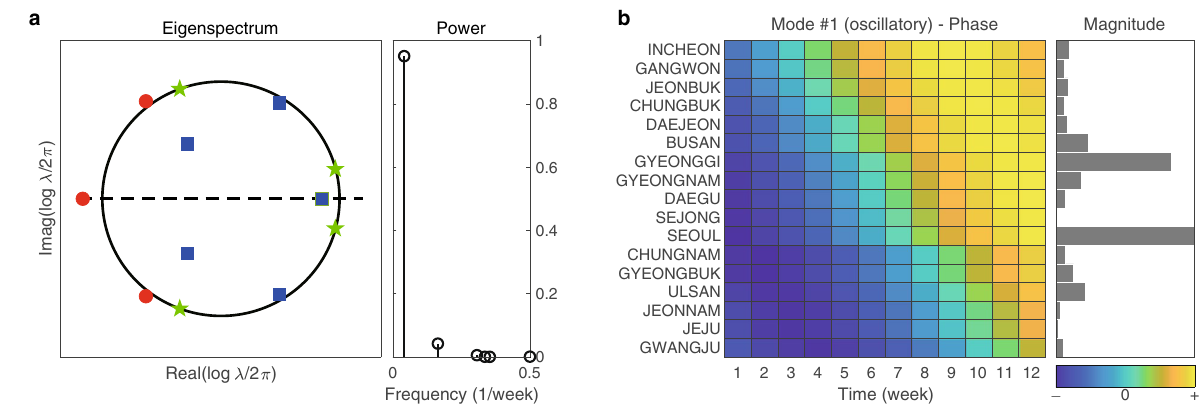
Figure 6. After the third wave: DMD eigenvalues and modes. ( a ) shows eigenspectrum { (cid:31) j } j = 1, ··· in the left and p |� α j φ j � F } j = 1, ··· , in the right. The first two DMD modes of highest powers are enumerated powers, defined as {| (cid:31) j as #1 and #2 . In this wave, the only one DMD mode of the dominant power is selected. ( b ) shows the phase and magnitude of the selected DMD mode. In the phase diagram, regions, whose phases are similar are Time dependent spatial variation of COVID‑19 in South Korea.